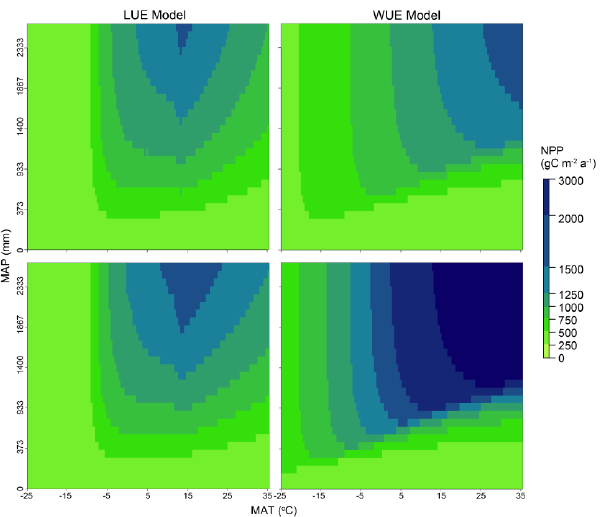
Fig. 7. Annual NPP responses to mean annual temperature (MAT) and mean annual precipitation (MAP) predicted by the LUE and WUE models under recent (upper panel) and doubled (lower panel) [CO2]. Seasonal cycles of monthly values corresponding to each value of MAT were obtained by adding a constant to the mean sea- sonal cycle across all the NPP mensuration plots. Monthly values corresponding to each value of MAP were obtained by multiplying the mean seasonal cycle by a constant. These conventions provide a reasonable approximation to the range of climatic conditions found in